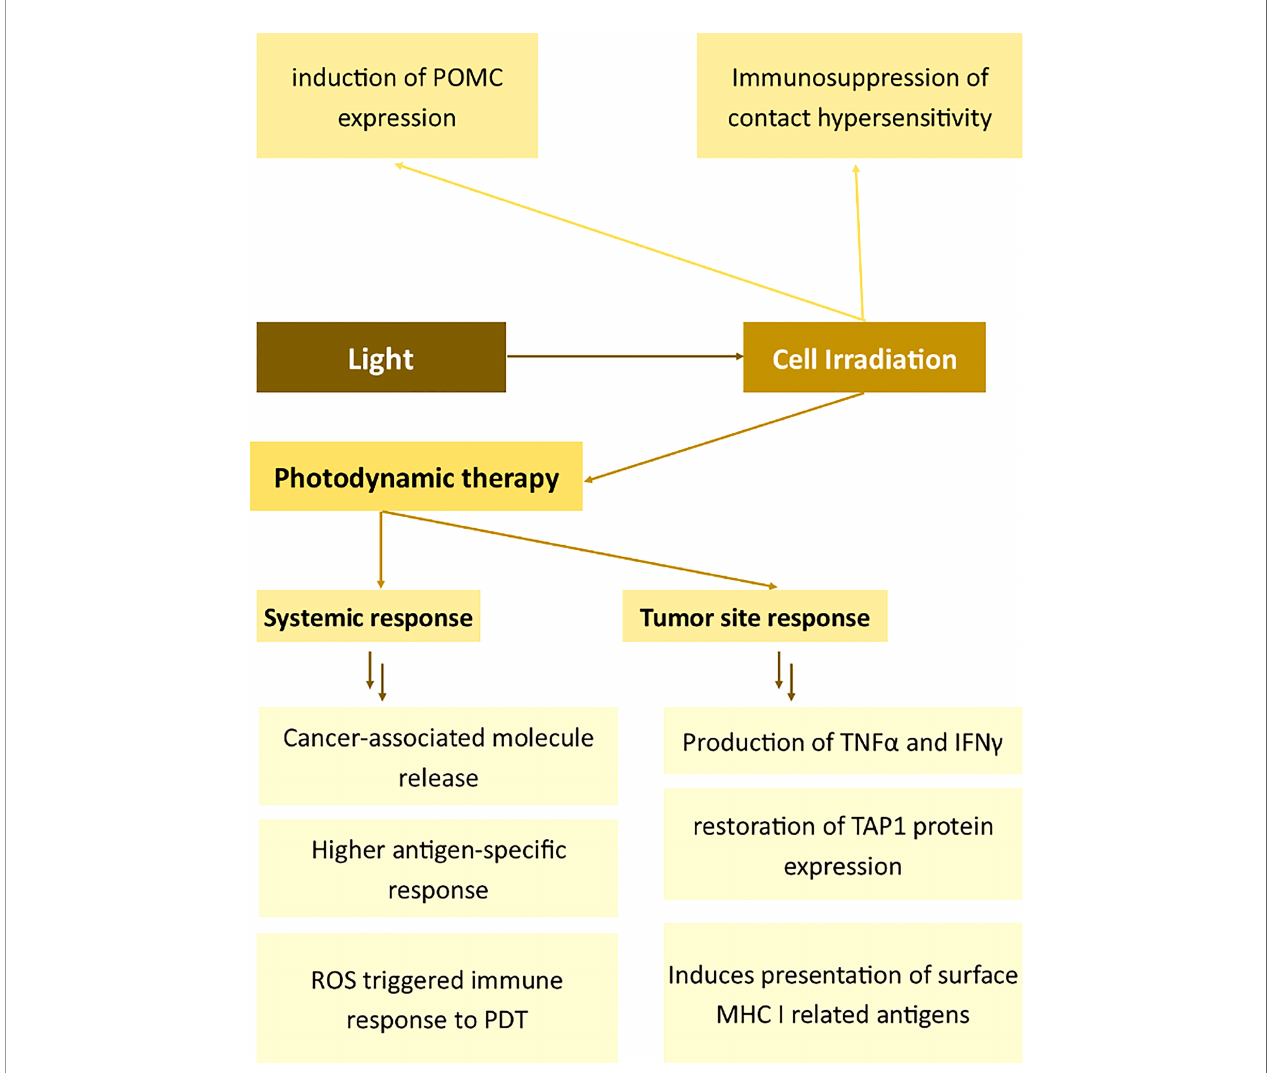
FIGURE 5 | Effects of light on the expression of membrane antigens. Proopiomelanocortin (POMC), Tumour Necrosis Factor a (TNF a ), Interferon g (IFN g ), Transporter associated with antigen processing 1 (TAP1), Major Histocompatibility Complex I (MHC I), Photodynamic therapy